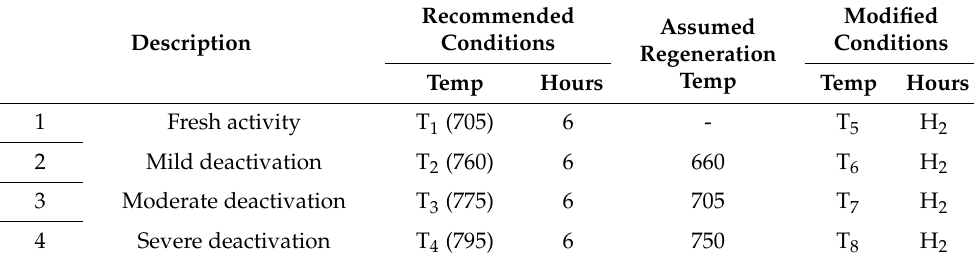
Table 1. Steaming conditions for hydrothermal deactivation evaluation.